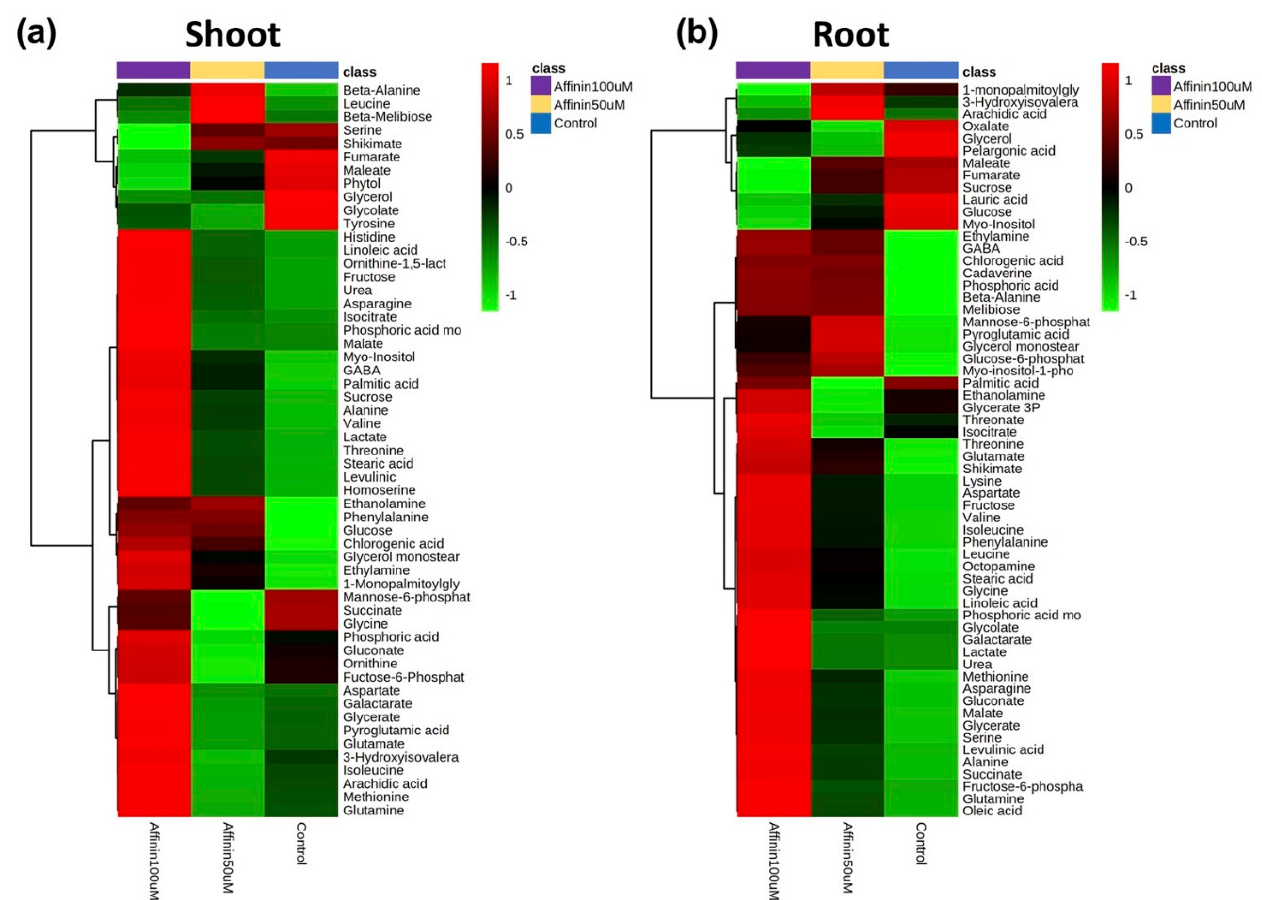
Figure 3. Heatmaps of changes in the average metabolite abundance in tomato ( a ) shoots and ( b ) roots in response to affinin treatments. Mean metabolite abundance for each sample type is shown: red, higher abundance; green lower abundance ( n = 3).